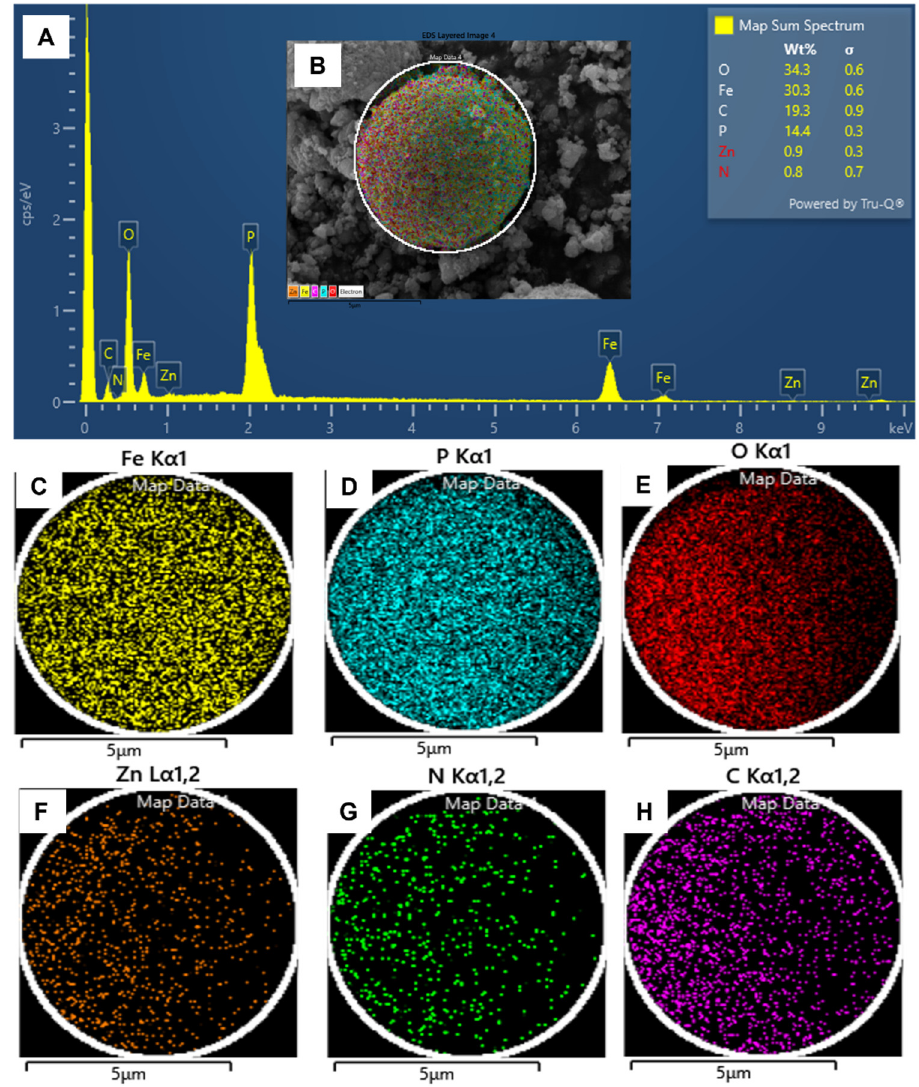
Figure 2. ( A ) EDX spectral analysis of the 2 wt.% ZIF-8@LFP [A]/MWCNT composite. ( B ) EDX